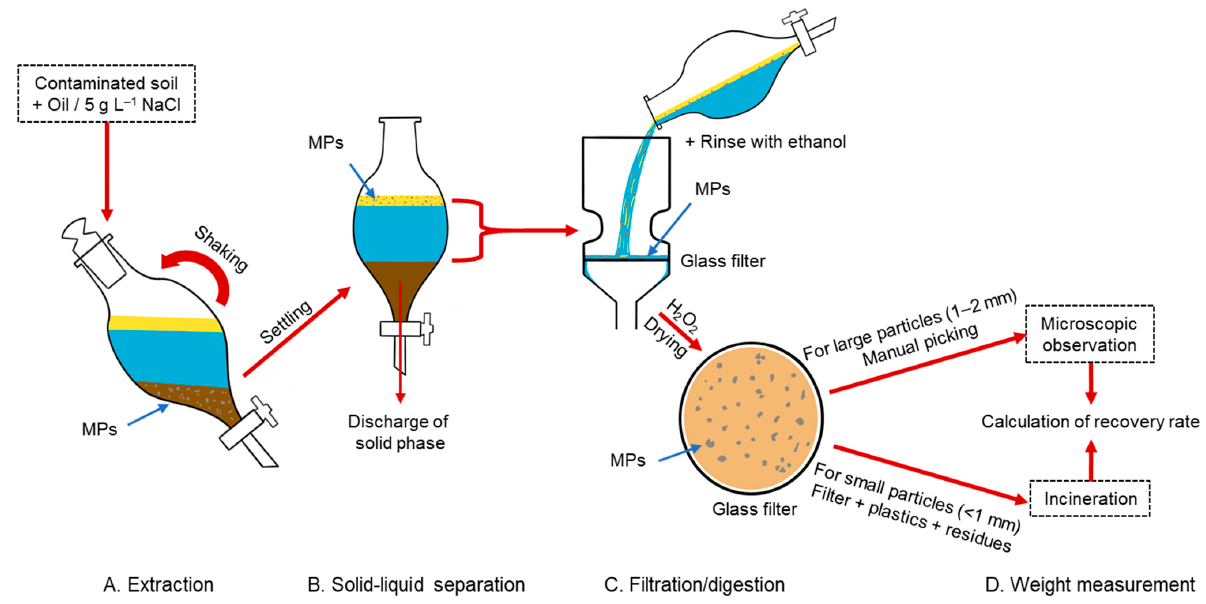
Figure 1. The procedure of the method in this study.